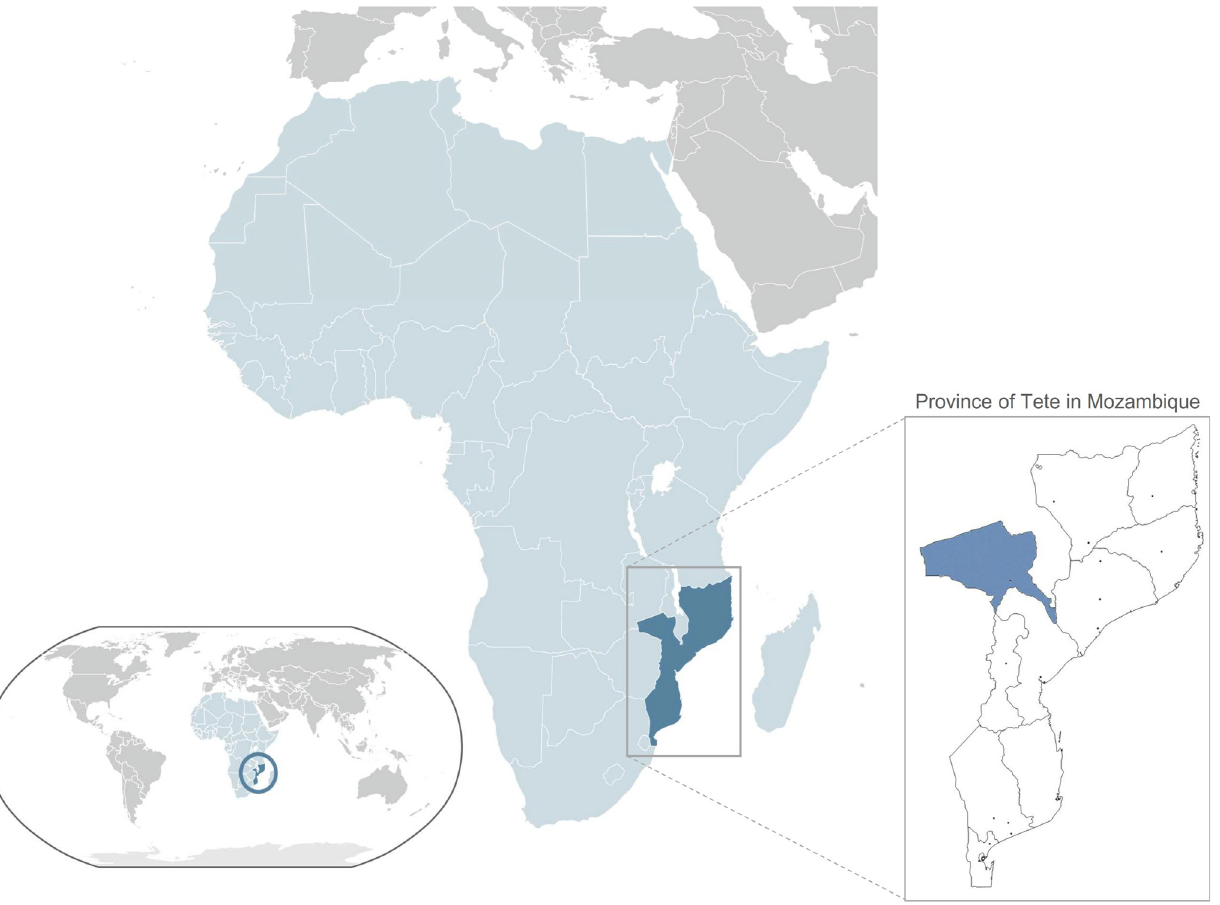
Fig 1. Geographical situation of the study area.